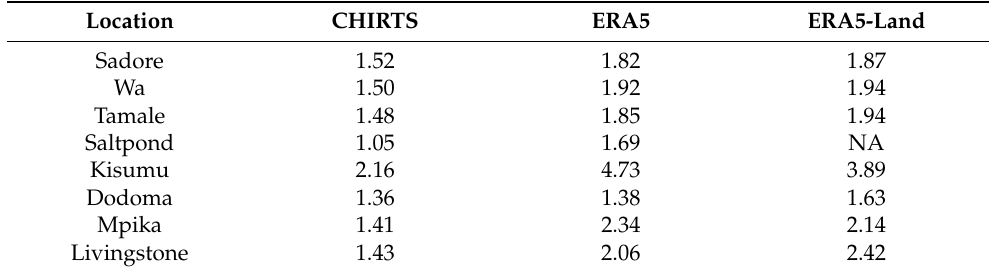
Figure 8. Bias between station maximum temperature and CHIRTS (blue), ERA5 (red) and ERA5- Land (green) for each month at the stations in Niger and Ghana ( a – d ) and Kenya, Tanzania and Zambia ( e – h ). The horizontal lines are at 0—a perfect bias score. Table 5. RMSE between daily station maximum temperatures and the three gridded products.